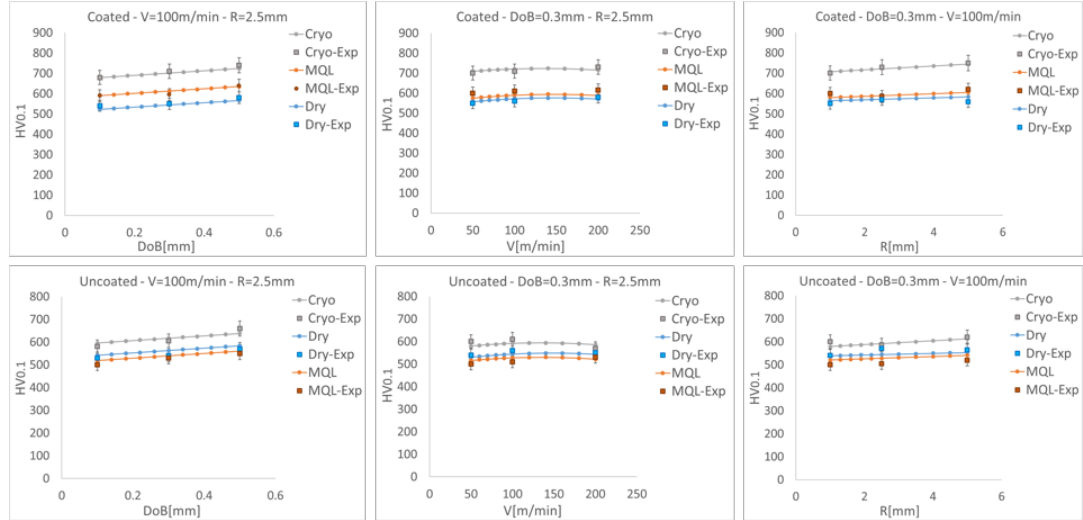
Figure 5. Hardness prediction for selected cases.